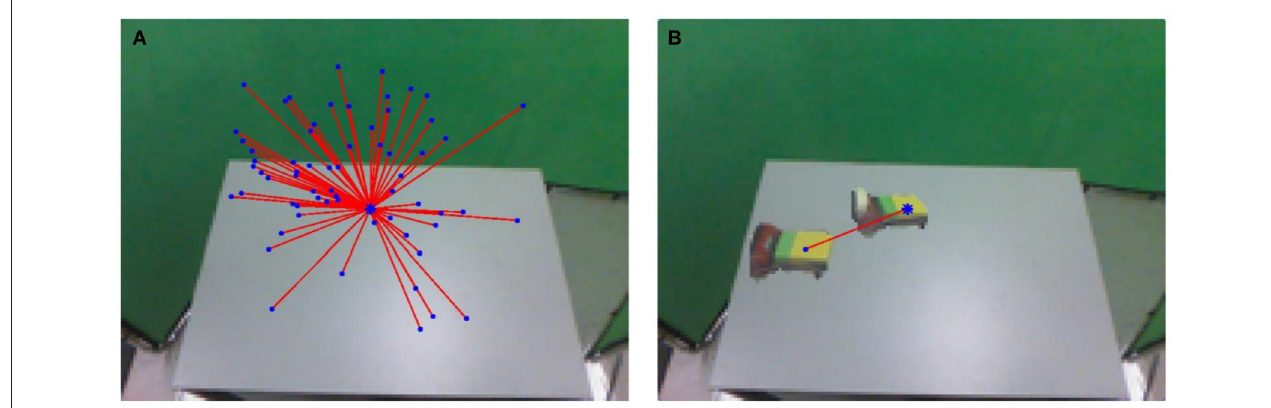
FIGURE 6 | (A) The agent considers the graph neighborhood around a node n i to estimate the change in appearance for small changes in configuration near n i . The predictions will be made by a local Jacobian estimate ˆ J ( n i ) (see Equation 12). n i is near the center of P and has a large number of neighbors. Each edge is relatively short in configuration space, where edge feasibility is measured, even though some neighbors appear distant in image space. The furthest neighbors tend to be those where most of the edge length comes from a difference in proximal joint angles that have a larger effect on workspace position. (B) The images of the node n i and one of its neighbors are superimposed with a representation of the edge, drawn between their centers of mass. This example illustrates a change in configuration 1 q and the resulting change in center locations 1 c along one